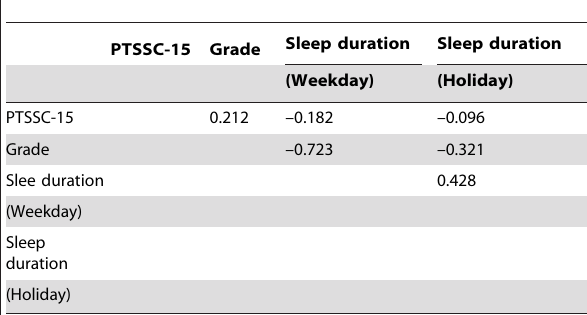
Table 6. Correlations between PTSSC-15, grade, and sleep durations on weekends and holidays in female